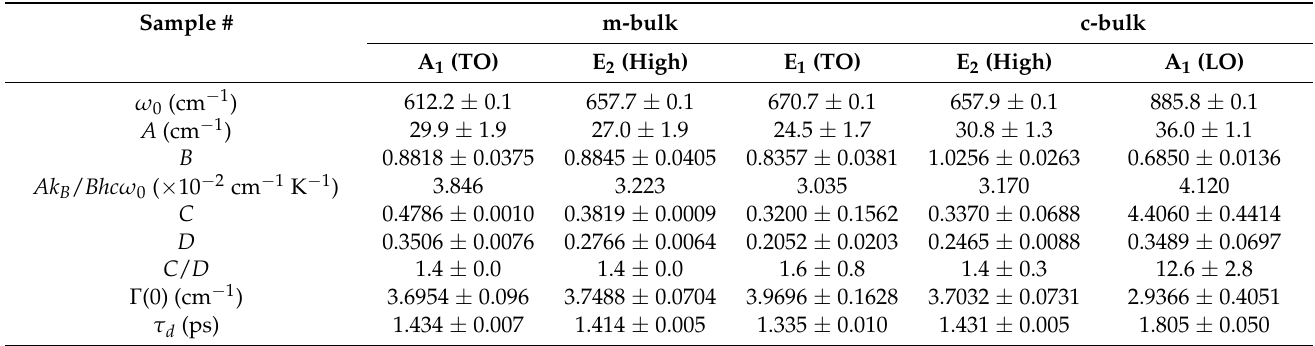
Figure 5. Raman shift ( a , b ) for m-bulk and c-bulk AlN crystals as a function of temperature. Table 3. Parameters ω 0 , A , B , Ak B / Bhc ω 0 , C , D , Γ (0), C / D , and τ d for the phonons of two bulk AlN